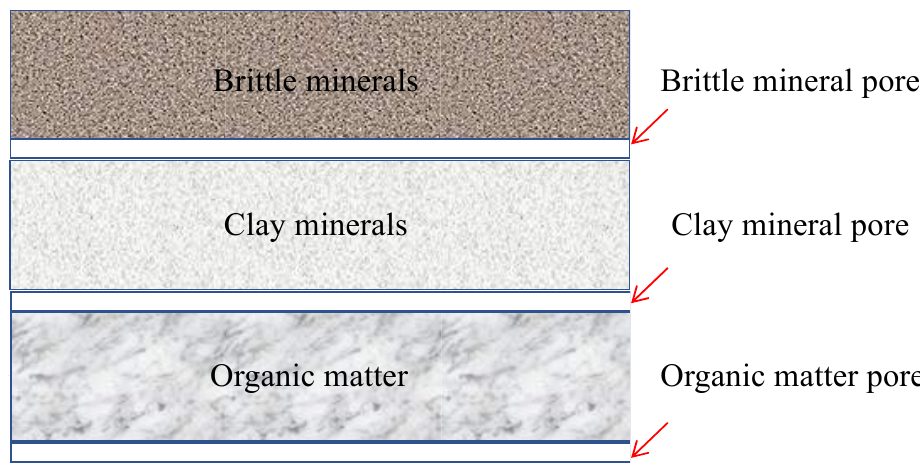
Figure 12. Physical model of the division of multiple types of pores.